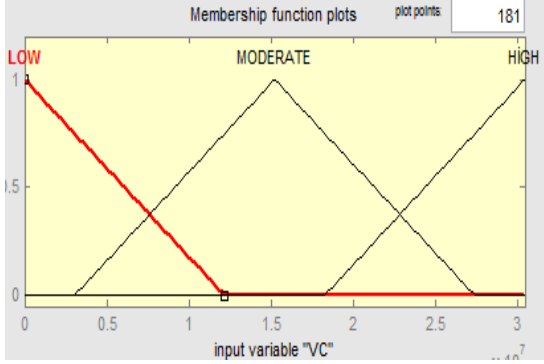
Figure 3. Variable Cost Membership Range